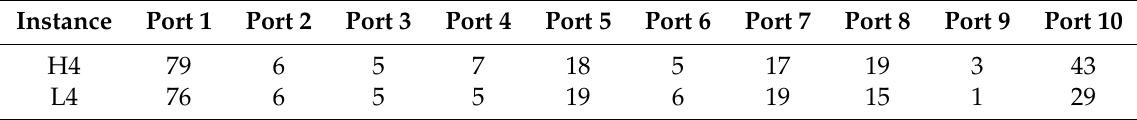
Table 4. Port calls for the best solutions. For the transshipment port (port 10) only the number of loading port calls is